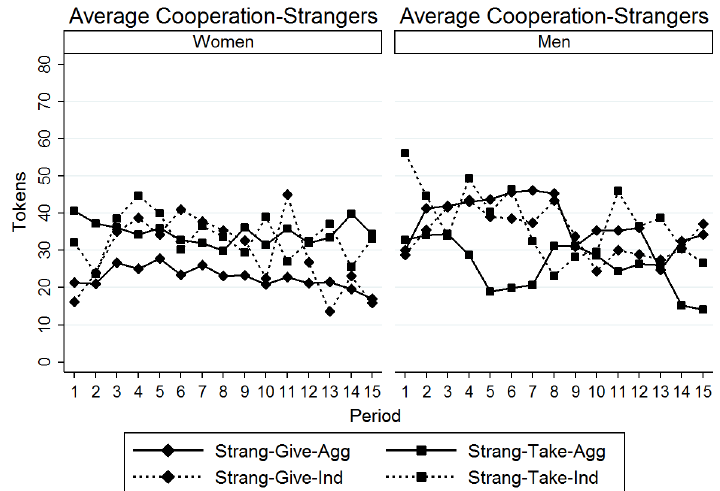
Figure 8. Average Cooperation Over Time